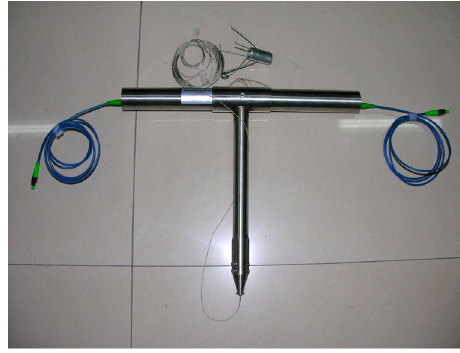
Figure 5. A packaged FBG roof separation sensor.